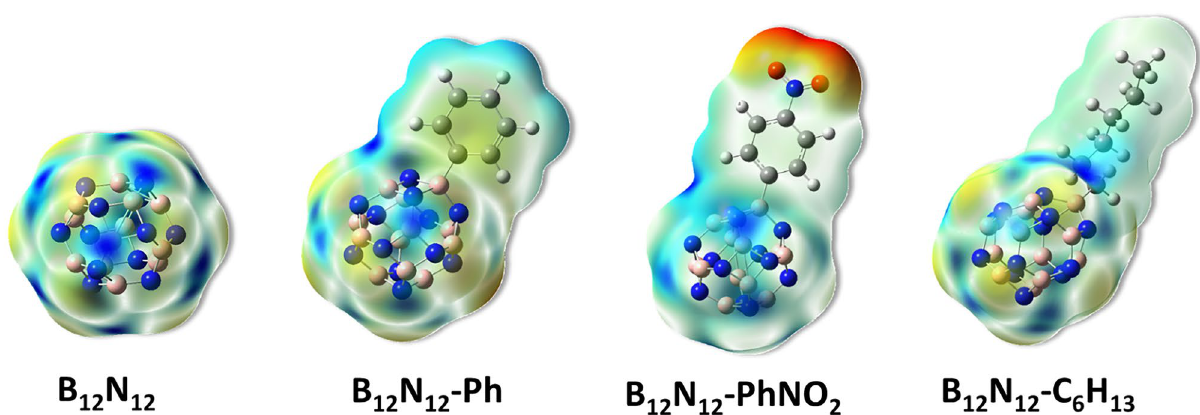
Figure 4. MEP surface bare and grafted B 12 N 12 nanocage